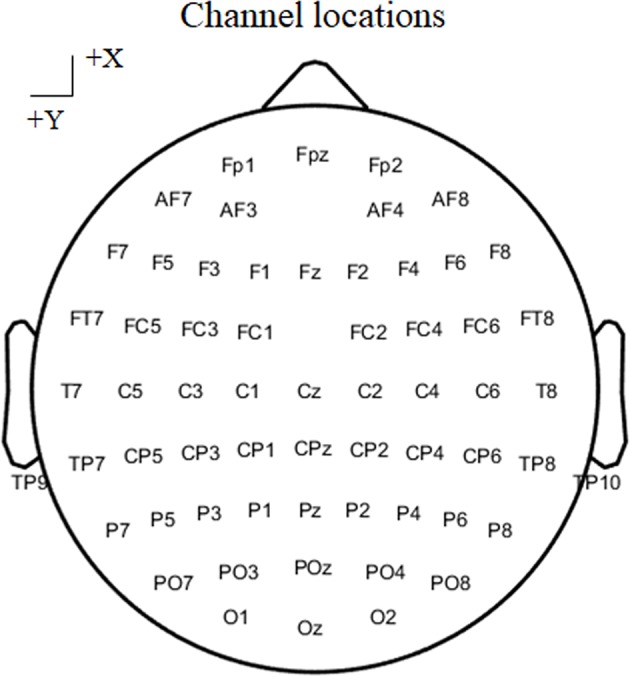
The position of channels according to the 10–20 cap system in real EEG data.